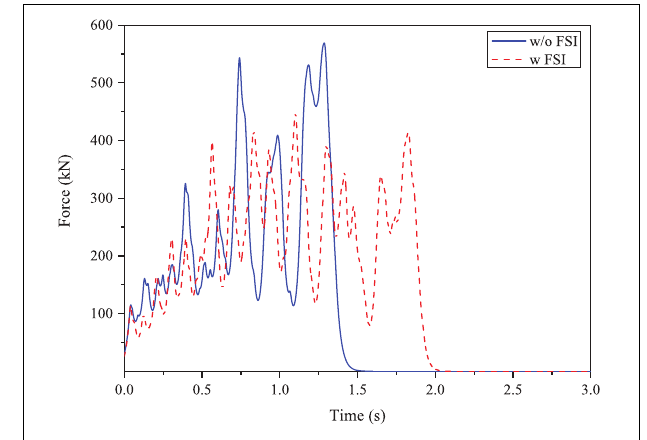
FIGURE 10 | Frequency domain characteristics of the structure displacement and ice force. FIGURE 11 | Comparison of ice force time